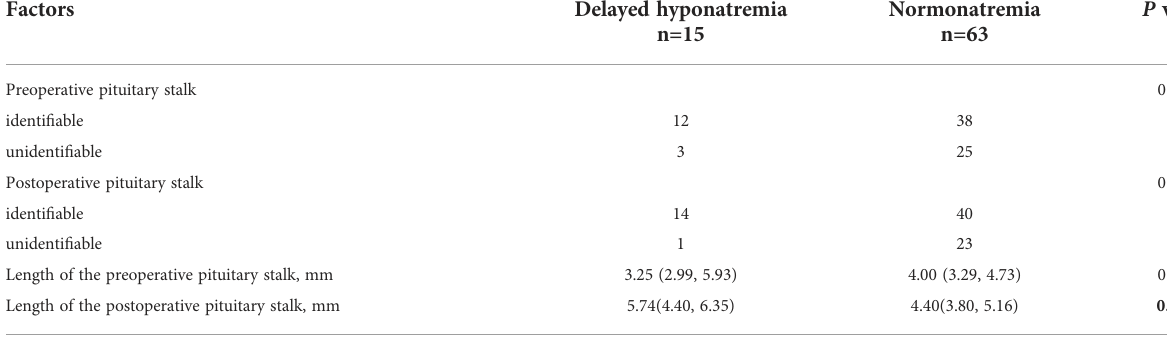
TABLE 2 Changes in the pituitary stalk after transsphenoidal surgery in patients with Rathke ’ s cleft cysts.